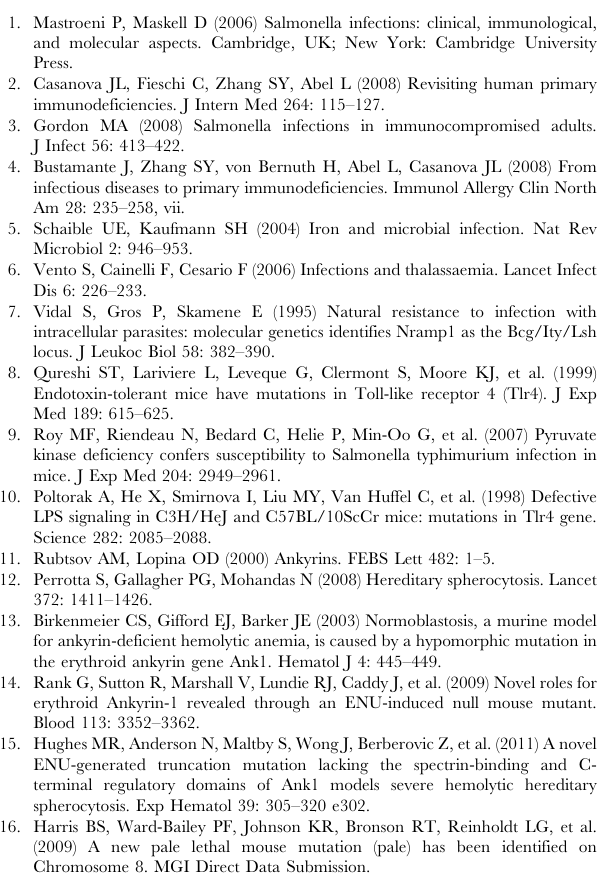
Table S1 Primer sequences used for quantitative PCR. Two housekeeping genes: Tbp (TATA box binding protein)